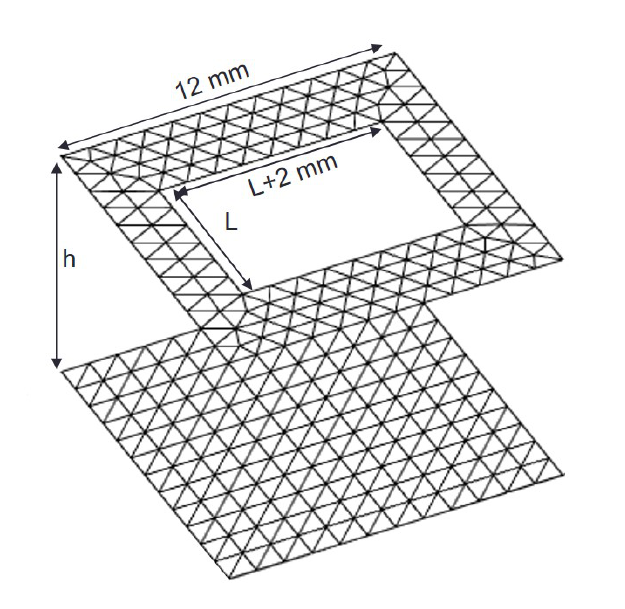
Figure 7: Rectangle-slot reflectarray element geometry and mesh.